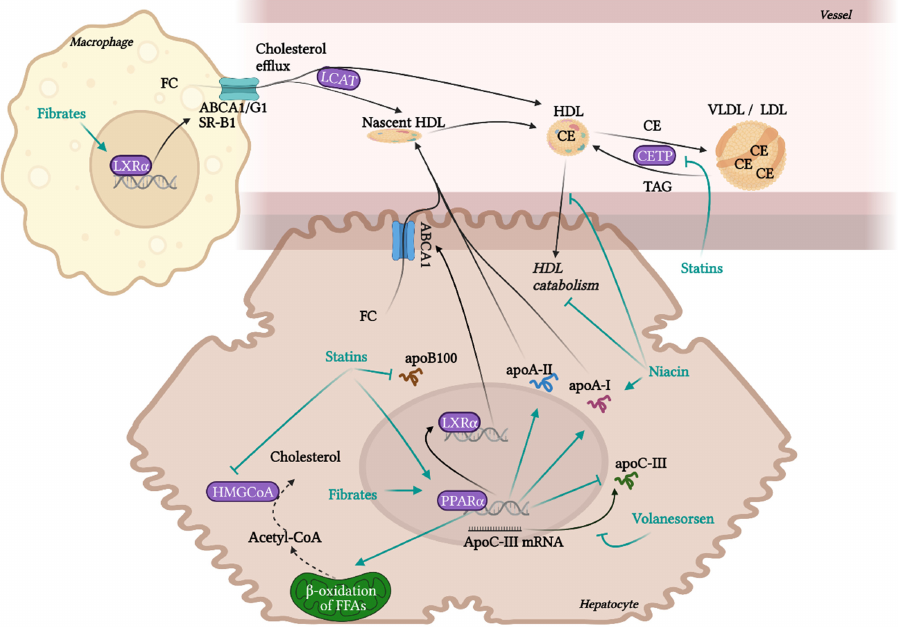
Figure 1. Simplified schematic representation of HDL-targeted therapies: Drugs in clinical practice. Apolipoprotein A-I (apoA-I); apolipoprotein A-II (apoA-II); Apolipoprotein B100 (apoB100); Apolipoprotein C-III (apoC-III); ATP-binding Cassette Receptor A1 (ABCA1); ATP-binding cassette receptor A1/G1 (ABCA1/G1); Cholesterol ester (CE); Cholesteryl ester transfer protein (CETP); Free Fatty Acids (FFAs); Free Cholesterol (FC); Hepatic scavenger receptor B1 (SR-B1); Lecithin-Cholesterol Acyltransferase (LCAT); Liver X Receptor α (LXR α ); Peroxisome Proliferator-Activated Receptor α (PPAR α ); Triacylglycerols (TAG). Created with BioRender.com (accessed on 15 September 2022).